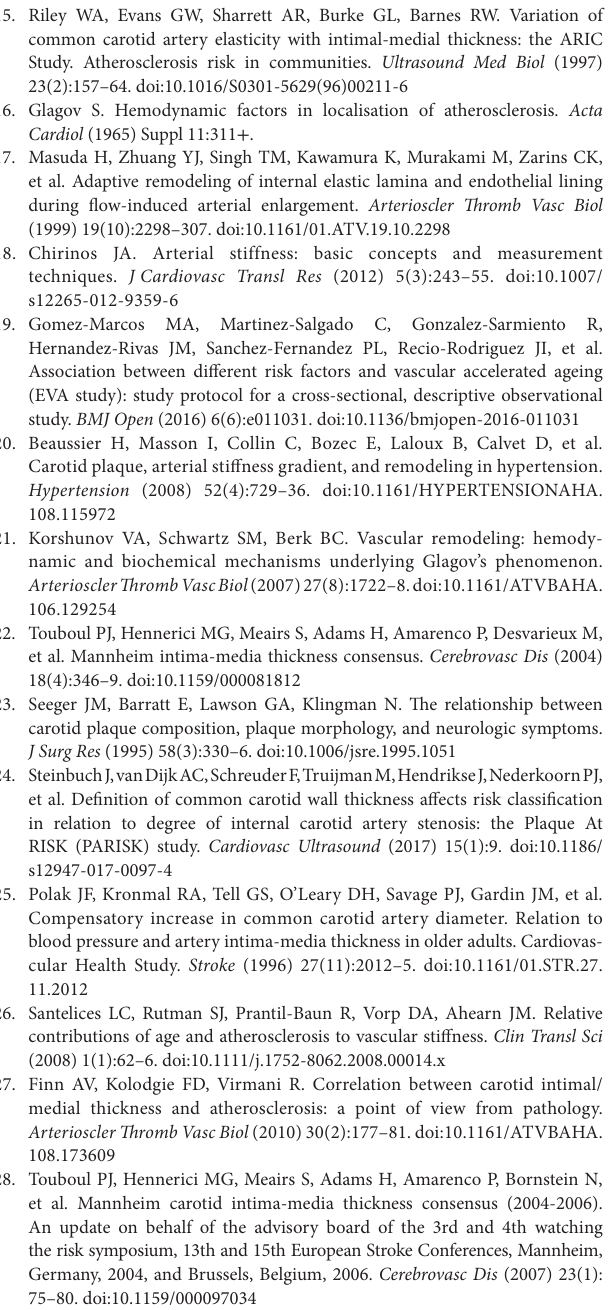
fiGUre s1 | Carotid Ultrasound procedures. High-resolution two-dimensional carotid ultrasound imaging was performed to measure carotid function and structure in 876 subjects from the Northern Manhattan Study (NOMAS). BP, blood pressure; CCA, common carotid arteries; cIMT, carotid intima media thickness; DBP, diastolic blood pressure; DD, diastolic diameter; ECA, external carotid arteries; ICA, internal carotid arteries; SBP, systolic blood pressure; DD, diastolic diameter; SD, systolic diameter; TPA, total plaque area (mm 2